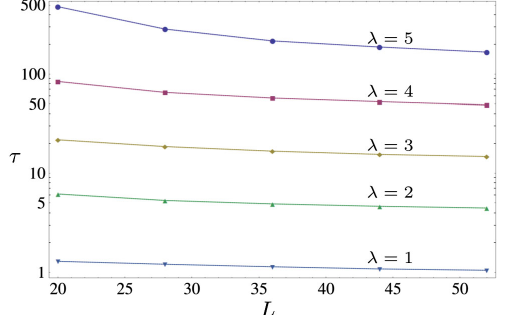
FIG. 11. Average lifetimes τ of the logical qudit stored in the ~ X ~ Z defect logical operators and illustrated in Fig. 4 as a function of code size L for λ ¼ 1 , 2, 3, 4, 5. Each data point represents 10 4 experiments. The lifetime is defined as the number of Metropolis steps divided by the number of spins in the